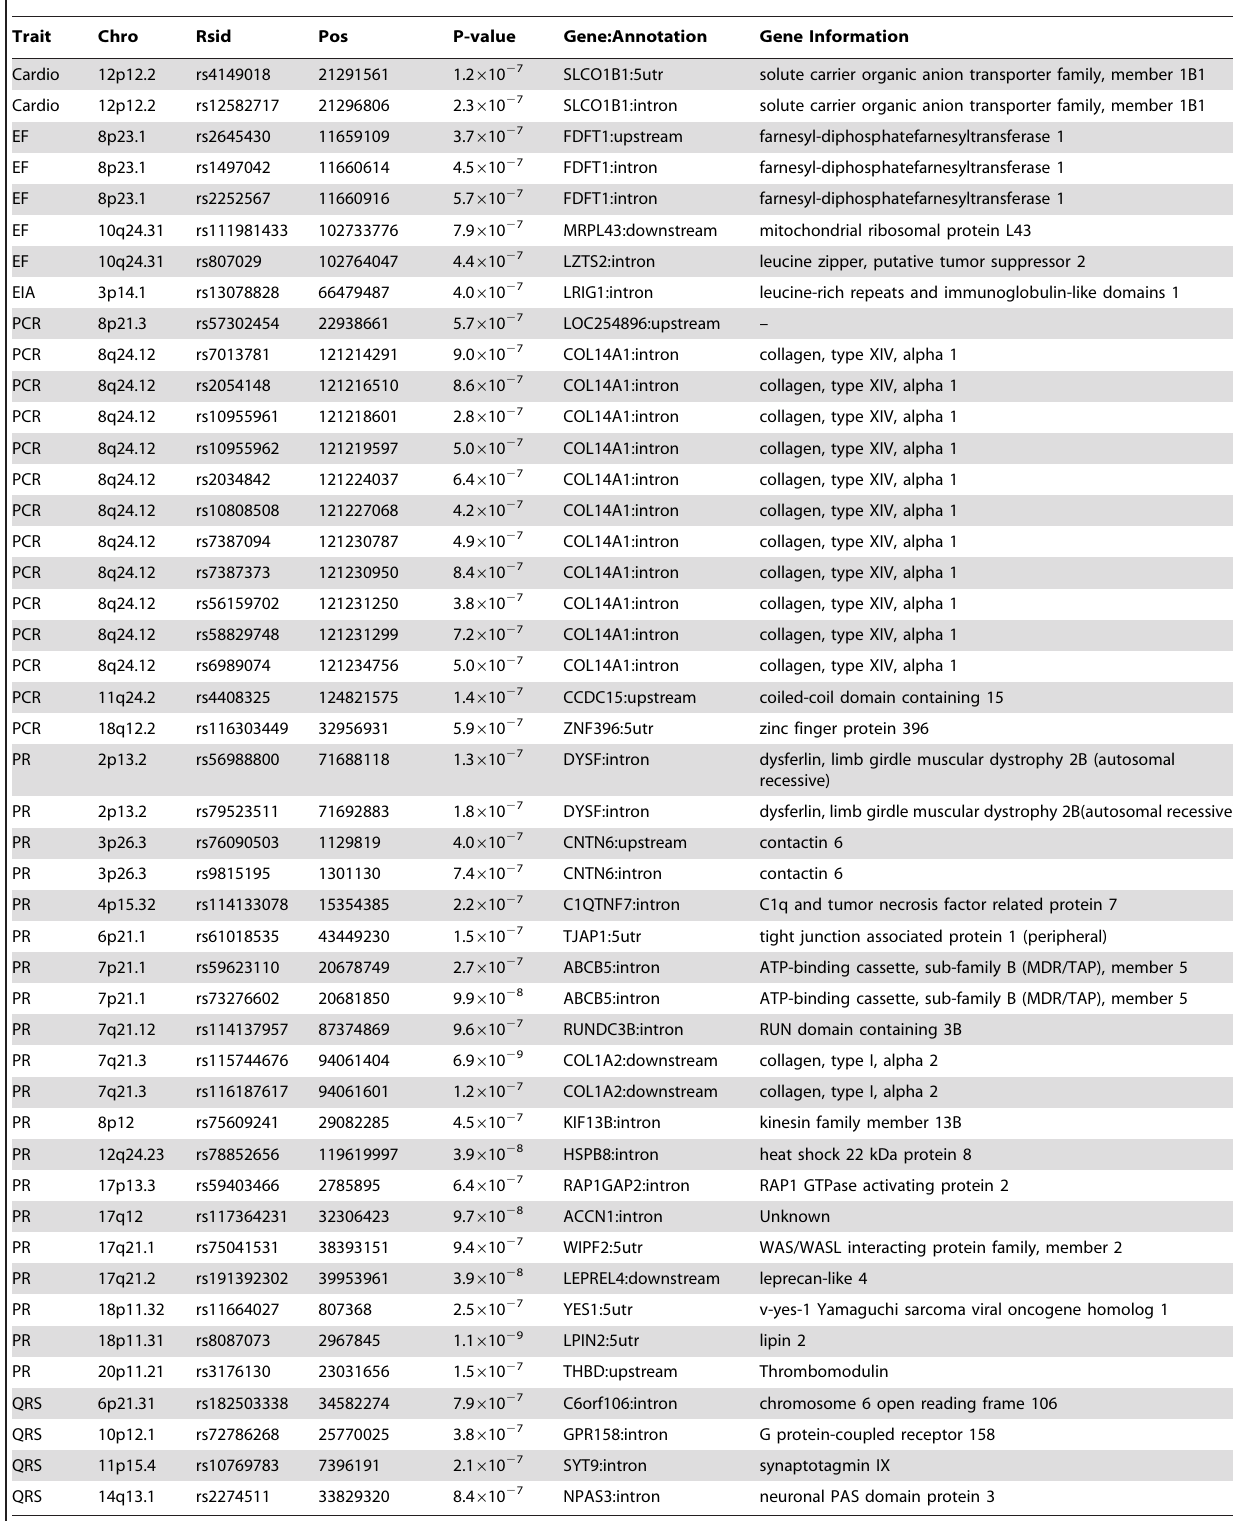
Table 1. Genomic positions that associated to traits (unadjusted P-value , 10 2 6 , intergenic positions not shown).